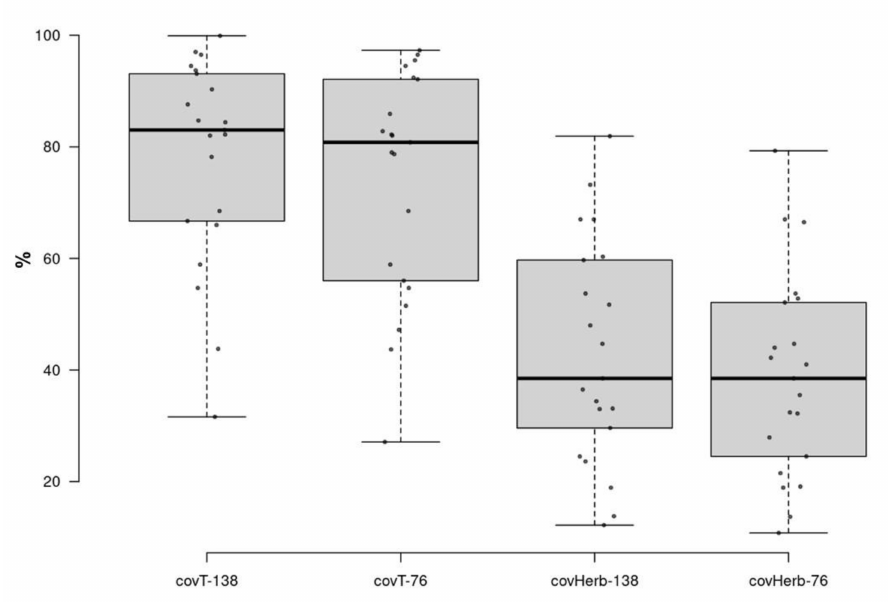
Figure 6. Total coverage (covT) by herbaceous plants including small balsam ( Impatiens parviflora ) and coverage by herbaceous plants (covHerb) without I. parviflora . Coverage data are provided for two cases: the total number of species (1) 138 (NSp-138); (2) 76 (NSp-76). Value for each population is indicated by dot.